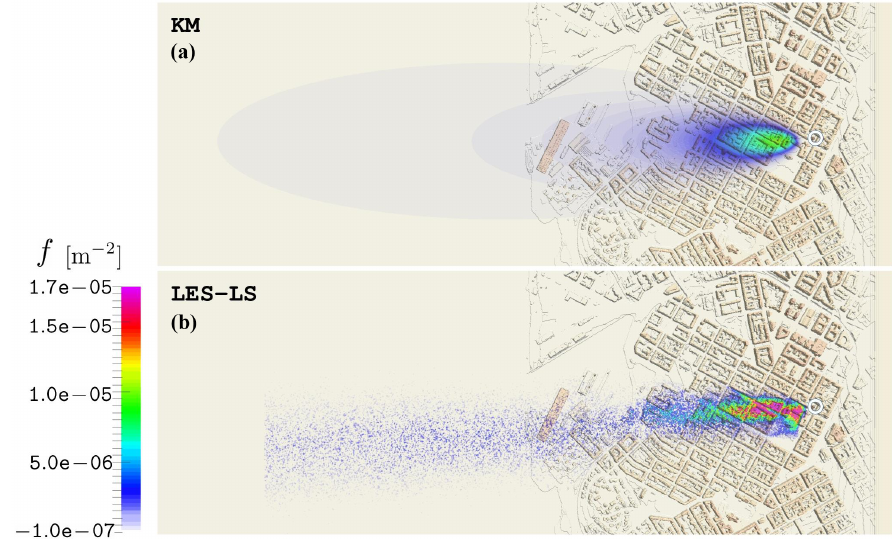
Figure 8. Comparison of identically normalized LES–LS (b) and KM (a) footprint distributions merged with the urban topography model of Helsinki. The location of the EC sensor (Hotel Torni) building is indicated with a white circle.